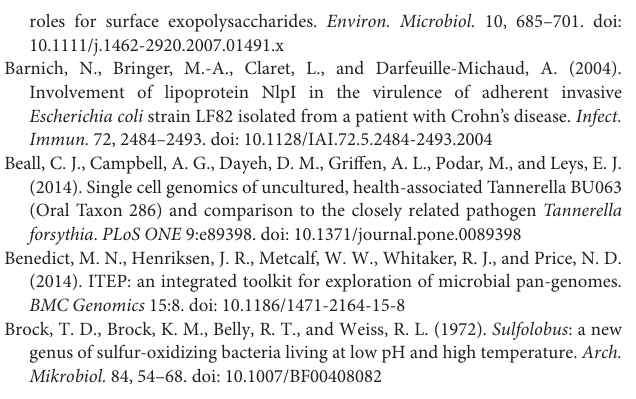
FIGURE S1 | Single copy conserved genes in genomes. Histograms are labeled with the gene name and y -axis depict the number of positive hits to hmmer models in a set of 43 single-copy genes which are conserved in most archaea (Lloyd et al., 2013). The 1-D plot summarize the data and the mode is used to estimate the number of genomes in the assembly. FIGURE S2 | Mismatches in common full length archaeal primers. Primer sequence alignment and predicted restriction digestion sites are annota- ted on the full length 16S rRNA gene sequence. Green annotations were assigned by the primer alignment software (CLC Genomics Workbench 6.5.2). Ambiguous base calling prevented the alignment of ARC-1492R to WOR_SM1_79. WORSM1-9f (5 (cid:48) -CCAGTTGATCCTGCTGG-3 (cid:48) ) and WORSM1 -1405r (5 (cid:48) -CCACTCGATTGGTTTGAC-3 (cid:48) ) were designed for this study. Data Sheet S1 | Homologs of archaeal replication machinery in Altiarchaeales genomes. An X indicates the presence of a gene in the genome. Data Sheet S2 | Workbook which contains abundances and annotations for each homologous protein identified during the comparative genome analysis. Each worksheet in this datasheet corresponds to the co-occurrence patterns described in Figure 5